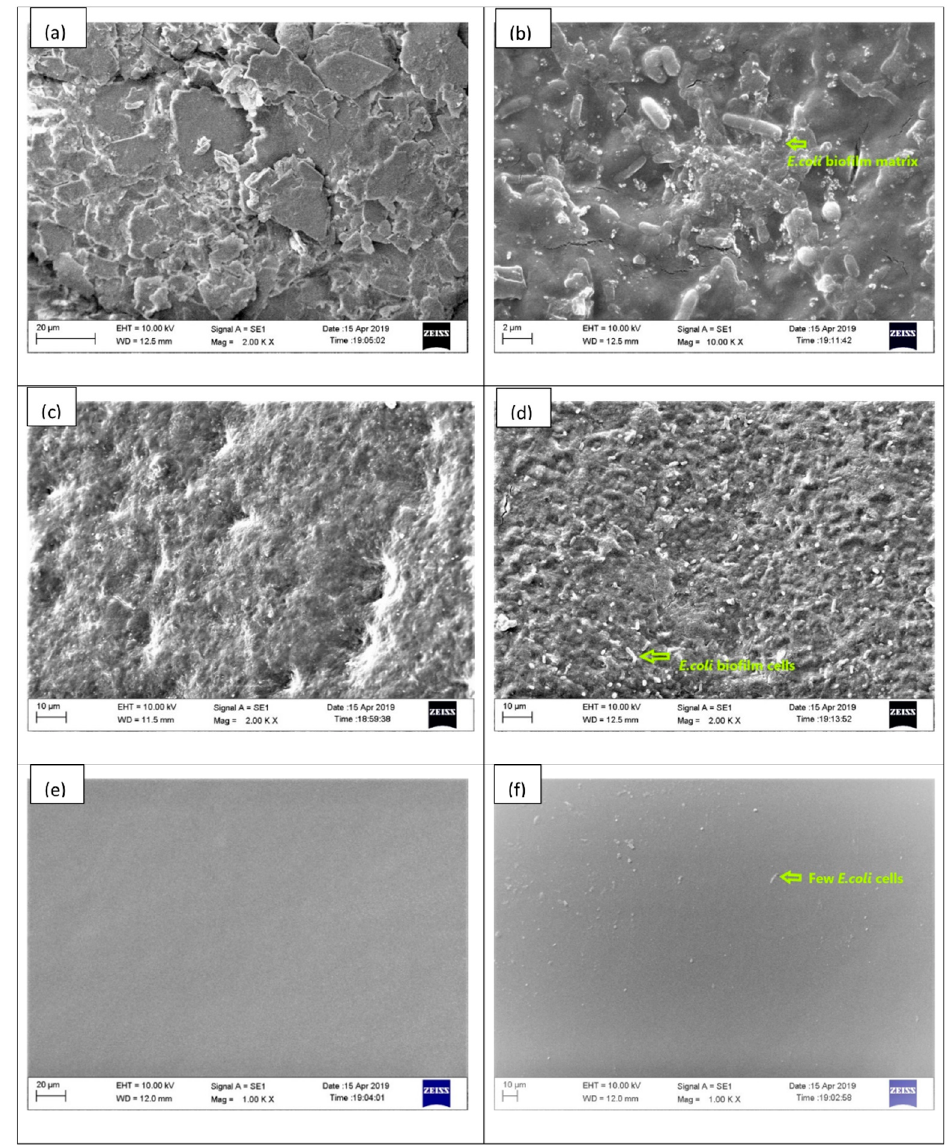
Figure 2. SEM images of catheter inner surfaces before and after E. coli biofilm formation; ( a ) rubber catheter; ( b ) biofilm over rubber catheter; ( c ) Foley catheter; ( d ) biofilm over Foley catheter; ( e ) endotracheal catheter; ( f ) biofilm over endotracheal catheter.